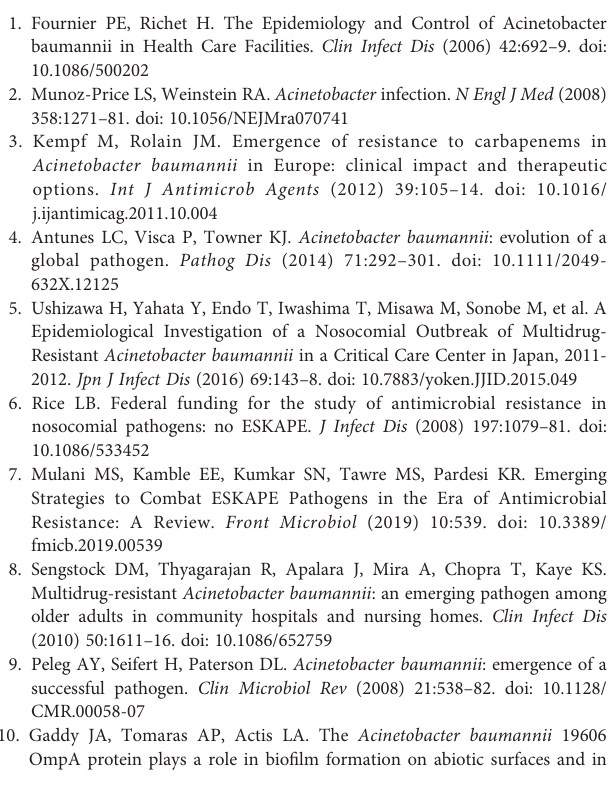
SUPPLEMENTARY FIGURE 3 | Phenotypic analysis of innate immune cells in the blood of Acinetobacter baumannii -infected and uninfected klotho wildtype (WT) mice. Innate immune cells in the blood of A. baumannii -infected and uninfected klotho WT mice were analyzed for their expression of the following cell-surface markers: CD11b, CD11c, Ly-6C, Ly-6G, and F4/80. A representative result of 4- color fl ow cytometric analysis of the innate immune cell population in blood cells from (A) an uninfected klotho WT mouse and (B) an A. baumannii -infected mouse at 1 day post-infection. Np, Neutrophils (CD11b + Ly-6G + ); M F , Macrophages SUPPLEMENTARY FIGURE 4 | Phenotypic analysis of innate immune cells in thebloodof Acinetobacterbaumannii -infectedanduninfectedklothoknockout(KO) mice. Innate immune cells in the blood of A. baumannii -infected and uninfected klotho KO mice were analyzed for their expression of the following cell-surface markers: CD11b, CD11c, Ly-6C, Ly-6G, and F4/80. A representative result of 4- color fl ow cytometric analysis of the innate immune cell population in blood cells from (A) an uninfected klotho WT mouse and (B) an A. baumannii -infected mouse at 1 day post-infection. Np, Neutrophils (CD11b + Ly-6G + ); M F , Macrophages SUPPLEMENTARY FIGURE 5 | Phenotypic analysis of innate immune cells in thespleenof Acinetobacterbaumannii -infectedanduninfectedklothowildtype(WT) mice. Innate immune cells in the spleen of A. baumannii -infected and uninfected klotho WT mice were analyzed for their expression of the following cell-surface markers: CD11b, CD11c, Ly-6C, Ly-6G, and F4/80. A representative result of 4- color fl ow cytometric analysis of the innate immune cell population in splenocytes